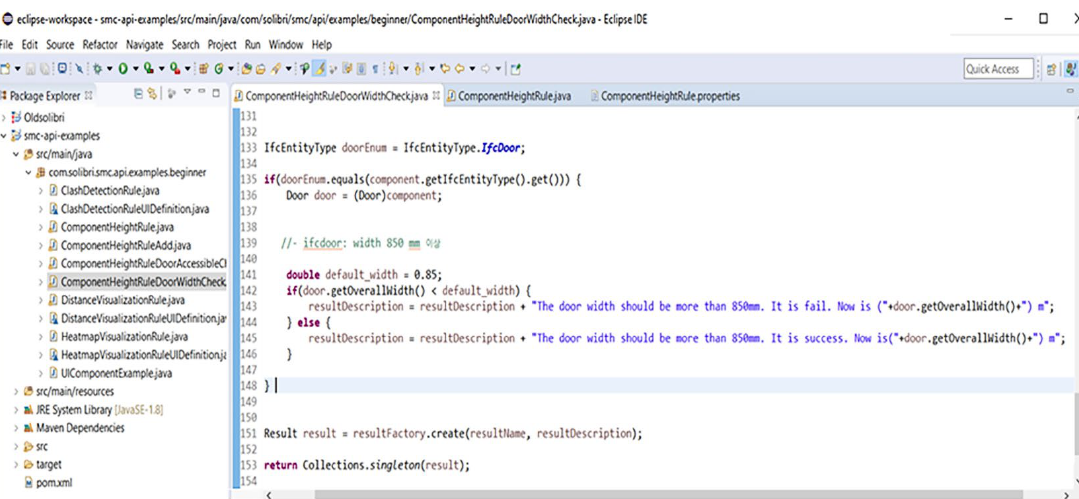
Figure 8. Example for developing the code checking rule for checking the door width